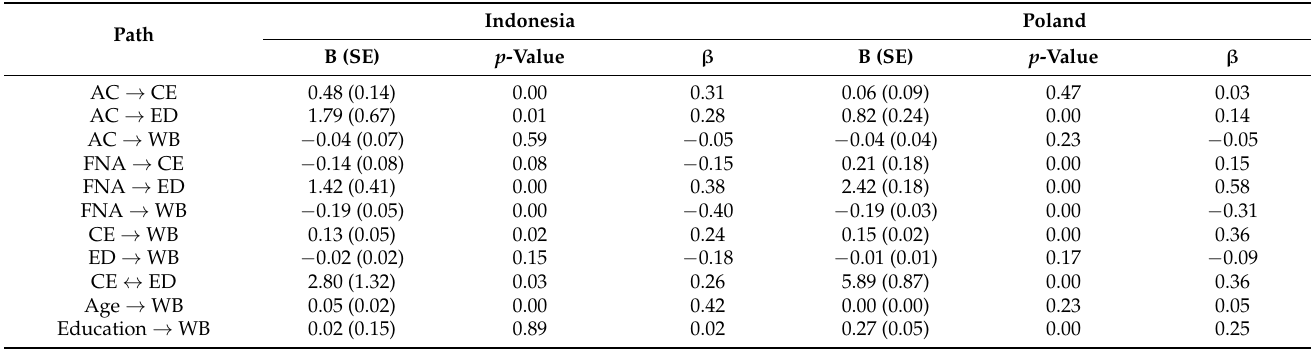
Table A1. Structural Equation Model